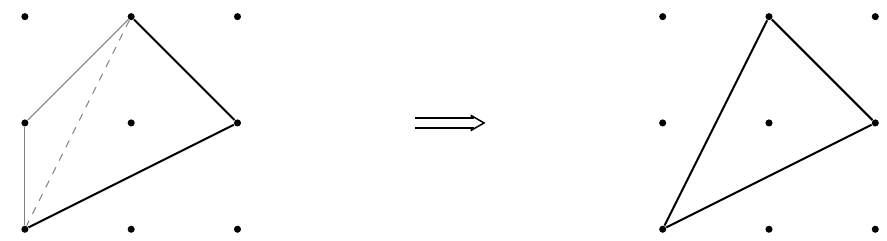
Figure 12. Higgsing dP 1 (left) takes out an external node from the toric diagram, resulting in C 3 = Z 3